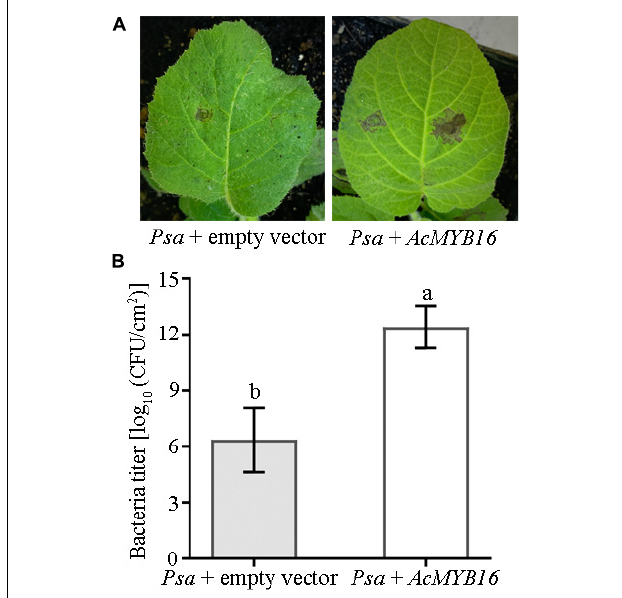
FIGURE 6 | Transient expression of AcMYB16 in ‘Jinkui’ leaves induced Psa infection (A) and enhanced plant sensitivity to Psa (B)